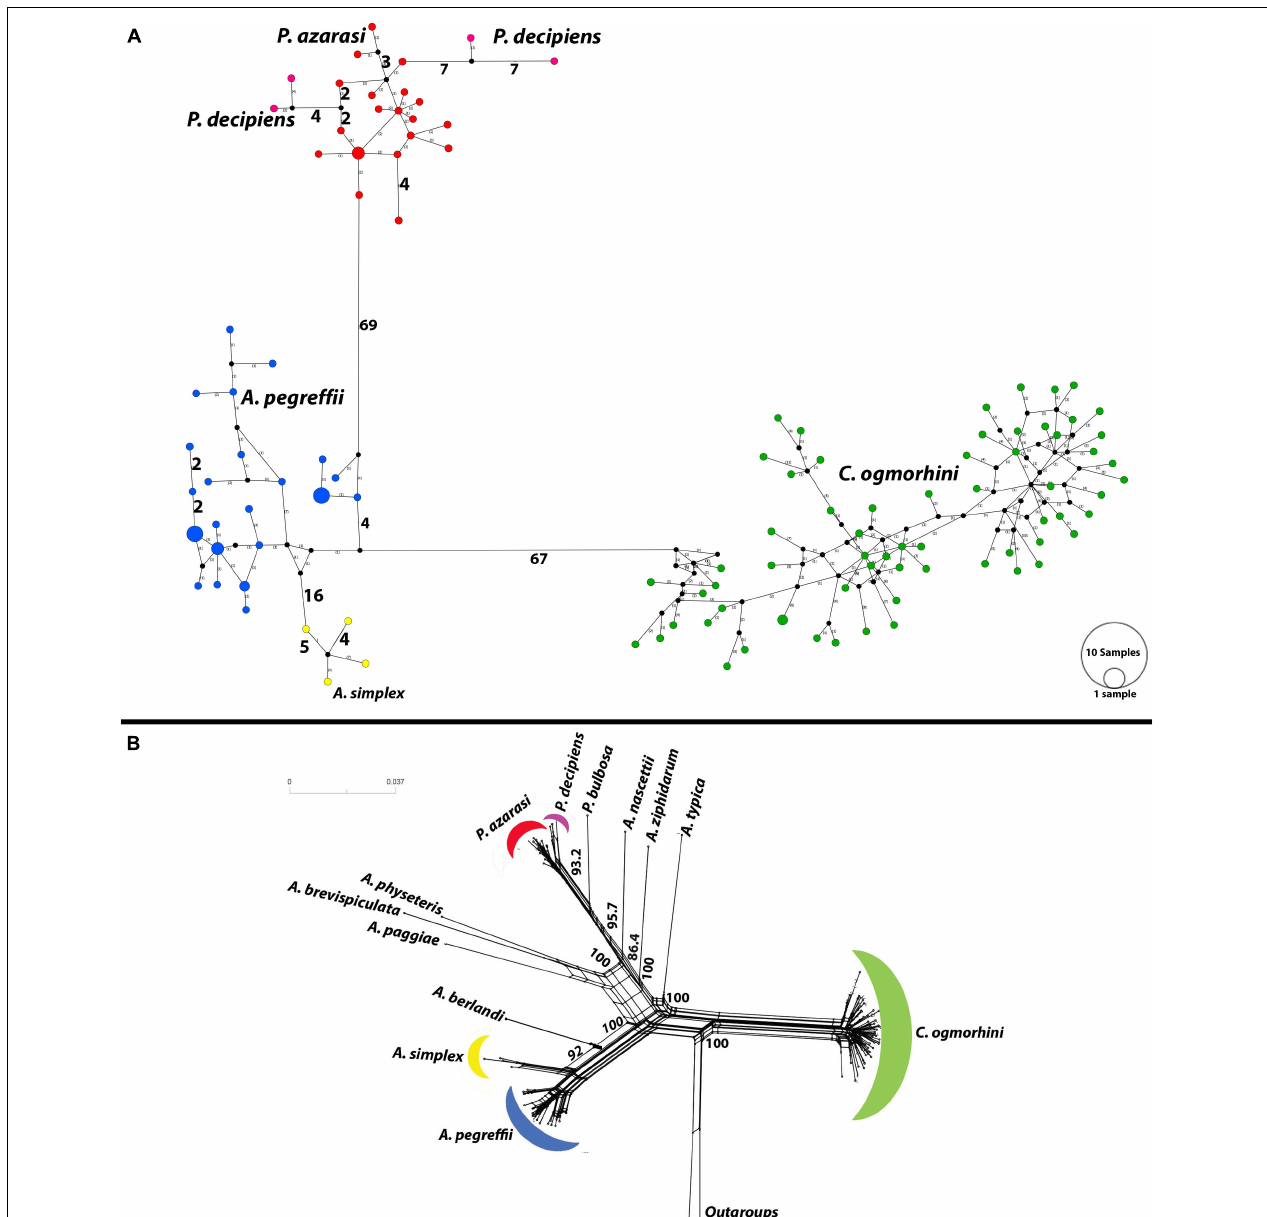
FIGURE 7 | Haplotype network using the 601 bp of cox2 dataset. (A) Median-joining network for anisakid populations with more than three samples. Symbol size and branch lengths are proportional to the number of shared individuals per haplotype and the number of mutational steps among haplotypes, respectively. Black circles indicate unsampled or extinct haplotypes. Sizes of circles are proportional to haplotype frequencies. (B) Split tree for 13 species of anisakids with uncorrected